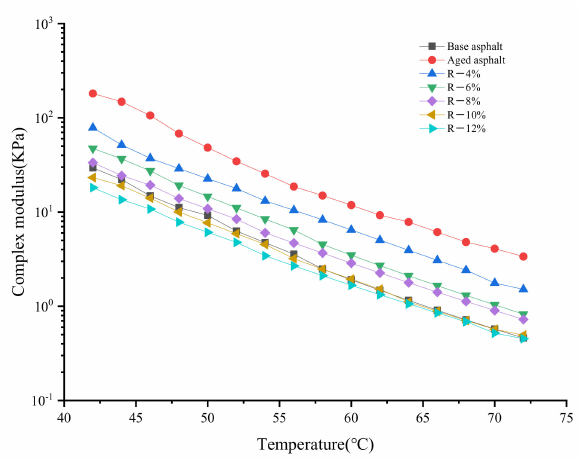
Figure 1. Test results of complex modulus ( G ∗ ) of aged asphalt after the regeneration.